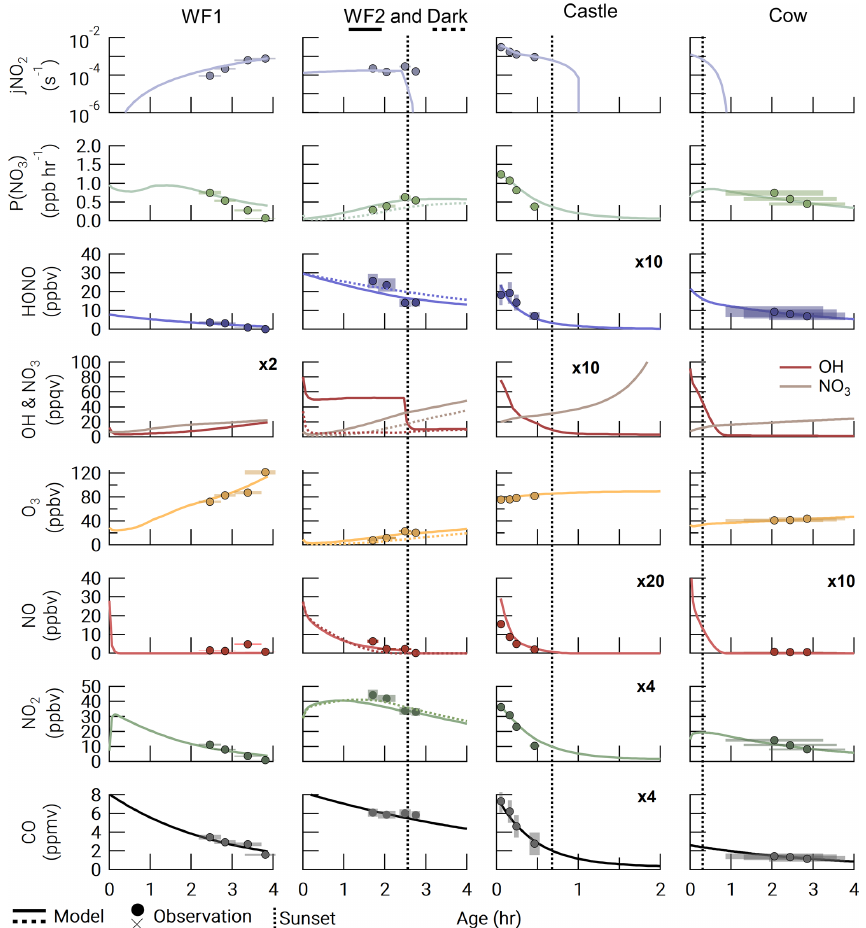
Figure 2. Observations (closed circles) and model output (lines) for all model runs. The Dark run is shown as a dashed line in the WF2 column. The time of sunset (defined as when the solar zenith angle reaches 90 ◦ ) is indicated by a vertical dashed line. Observation errors ( y error: variability in the observation at plume center and instrument uncertainty added in quadrature; x error: uncertainty in plume age determination) are shown as shaded xy